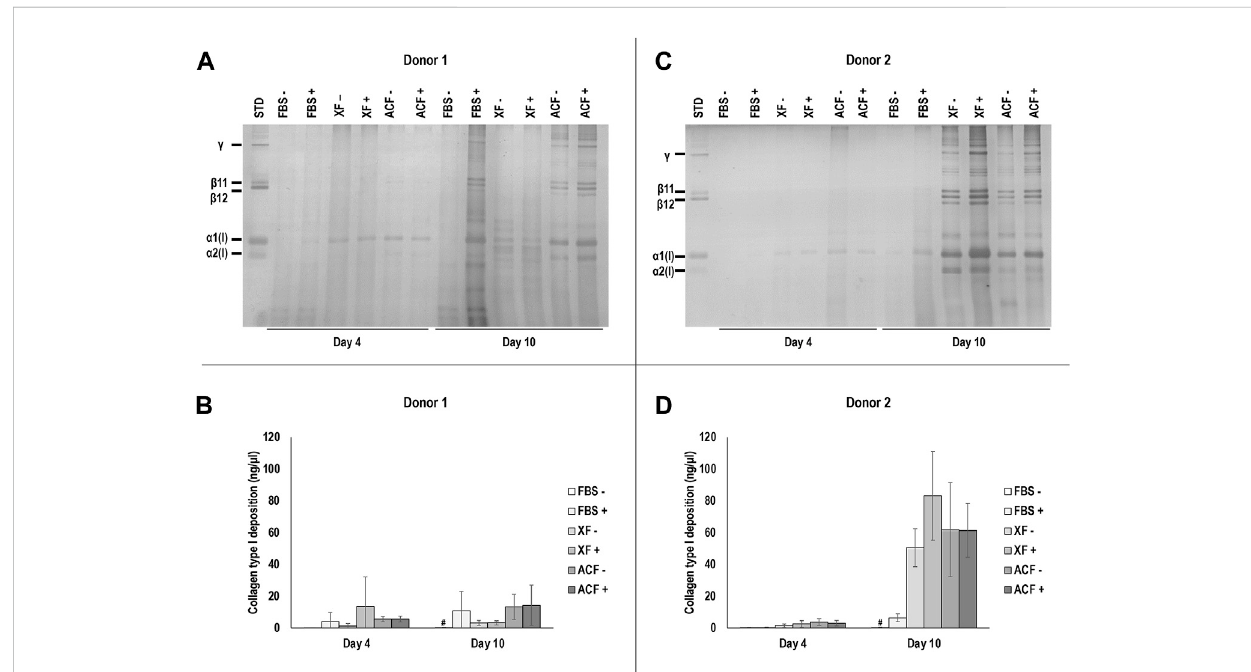
FIGURE 2 SDS-PAGE and corresponding densitometricanalysis ofhBMSCs of donor 1 (A, B) and 2 (C, D) at p4after 4 and 10 days of culture, expanded with or without MMC in ACF, XF and FBS containing media. Experiments for cells of each donor were performed in three technical replicates. # indicates the lowest statistically signi fi cant value ( p < 0.05) at a given time point.